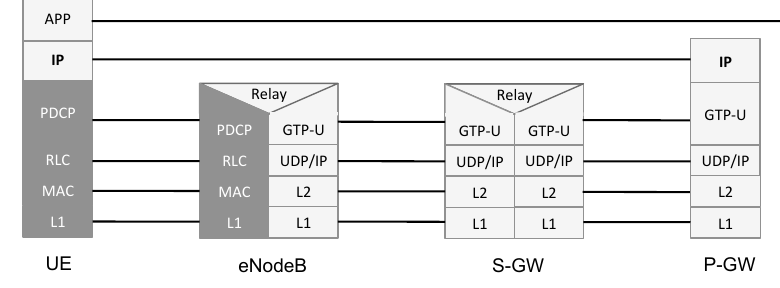
Figure 4. Current network protocols with IP-in-IP